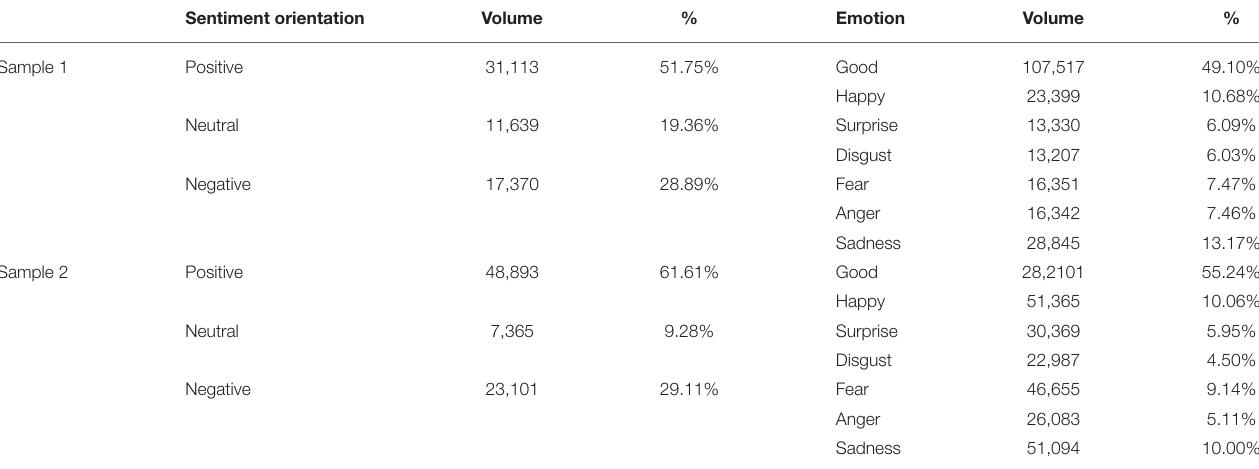
TABLE 3 | Results of sentiment